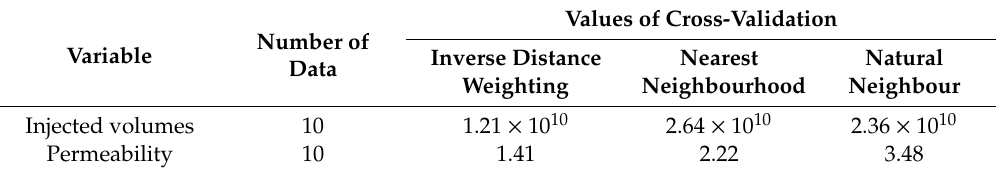
Table 2. Cross-validation values for 3 methods and 2 variables in the “L” reservoir.